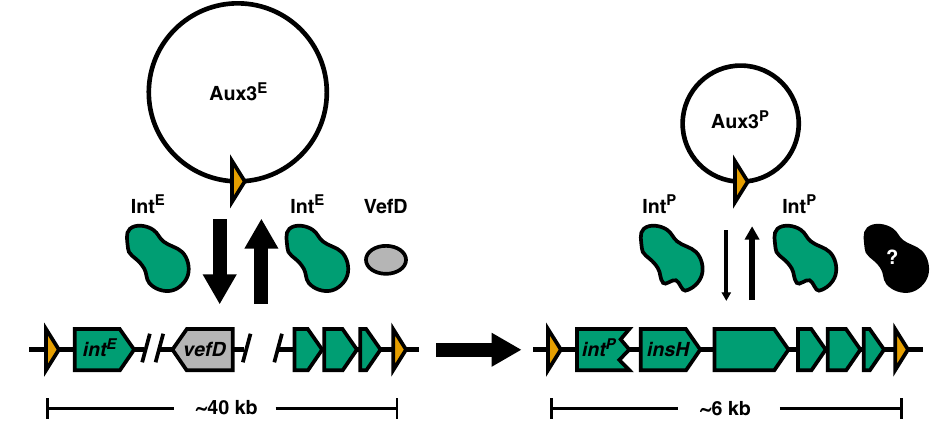
Fig. 6 Int E /VefD-mediated excision of Aux3 E is shut down in pandemic V. cholerae to maintain Aux3 P . Working model of Aux3 E site-speci fi c recombination (left) and degradation of the recombination machinery in the transition to pandemic V. cholerae (right). Genes conserved in Aux3 P are shown in green. Aux3 E speci fi c genes are shown in grey. Attachment sites ( att ) are shown in orange. Vertical arrow weight indicates relative quantities of integration and excision. Black protein indicates unknown